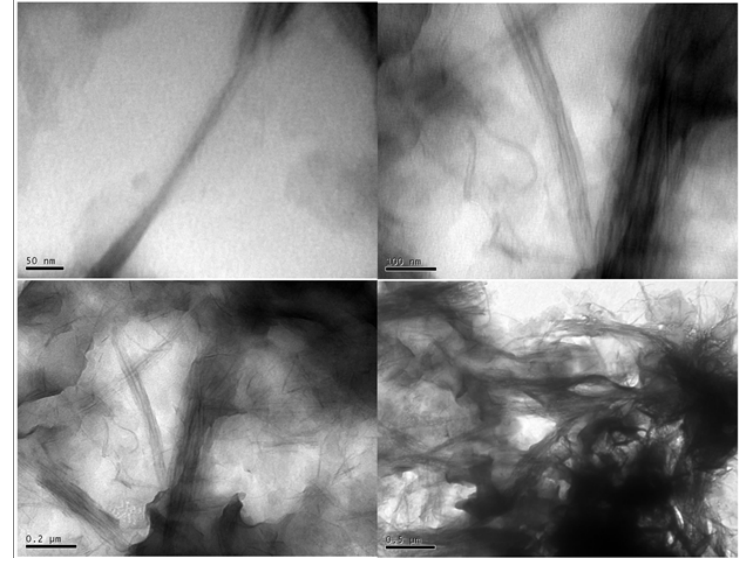
Figure 14. C-S-H TEM